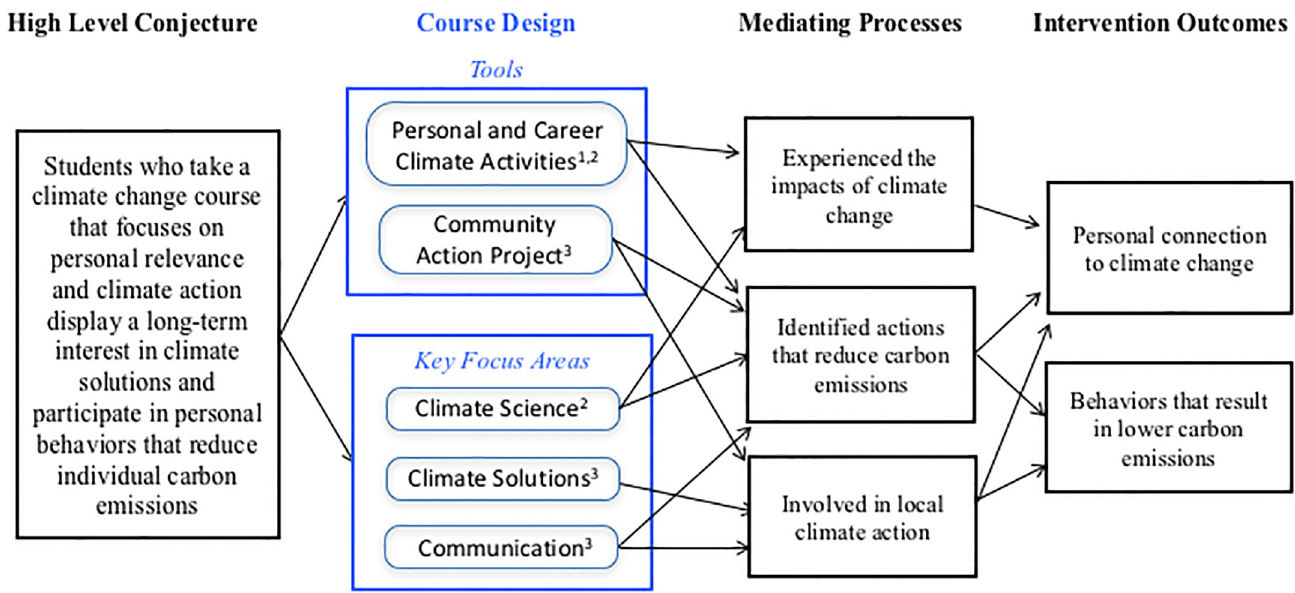
Fig 1. Conjecture map illustrating the connection between the course design elements, the mediating processes (e.g., observable interactions) and the intervention outcomes. In the course design column, the item superscripts indicate an alignment with predictor variables (i.e., 1—entry level; 2—ownership; 3—